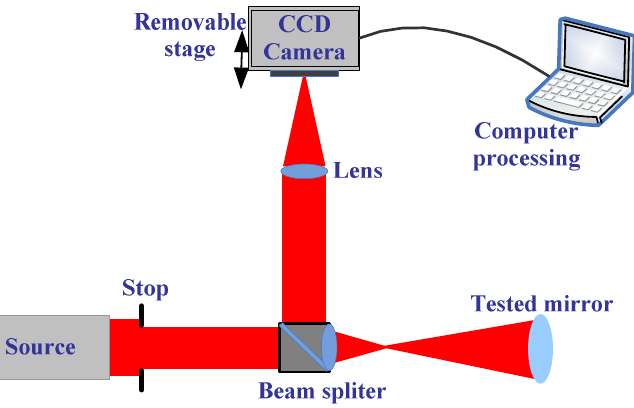
Figure 3. The schematic of the aspherical surface mirror measurement with the improved PR.